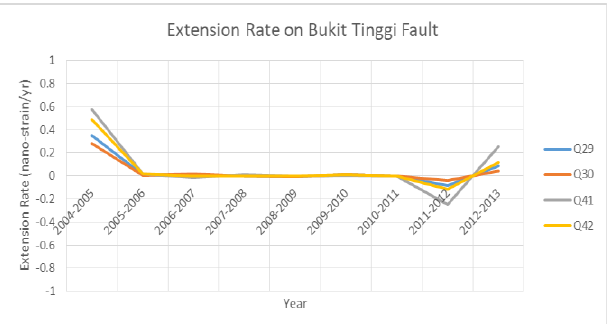
Figure 20. Extension rate changes on Bukit Tinggi Fault’s Quasi Network points (Q29, Q30, Q41 and Q42) from 2004 to 2013.